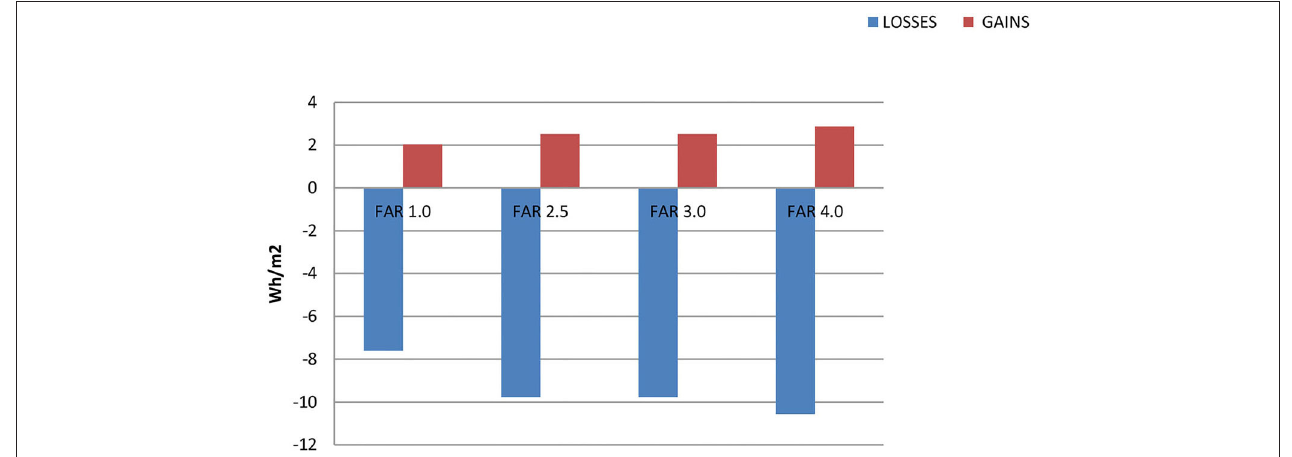
FIGURE 7 | Annual Energy gains and Losses based on FAR (y-axis: annual energy losses and gains in Wh/m 2 ; x-axis: FAR variations).